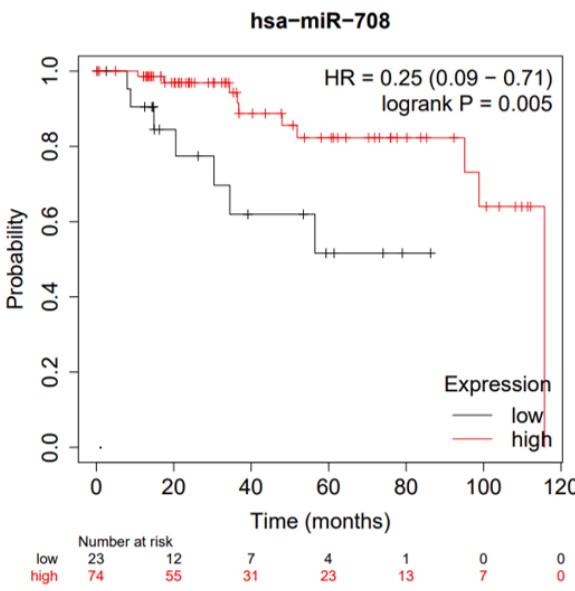
Figure 4. Mir-708 relevance in TNBC patients. Correlation between Overall Survival (OS) in TNBC and high (red) or low (black) miR-708 expression in the tumor.